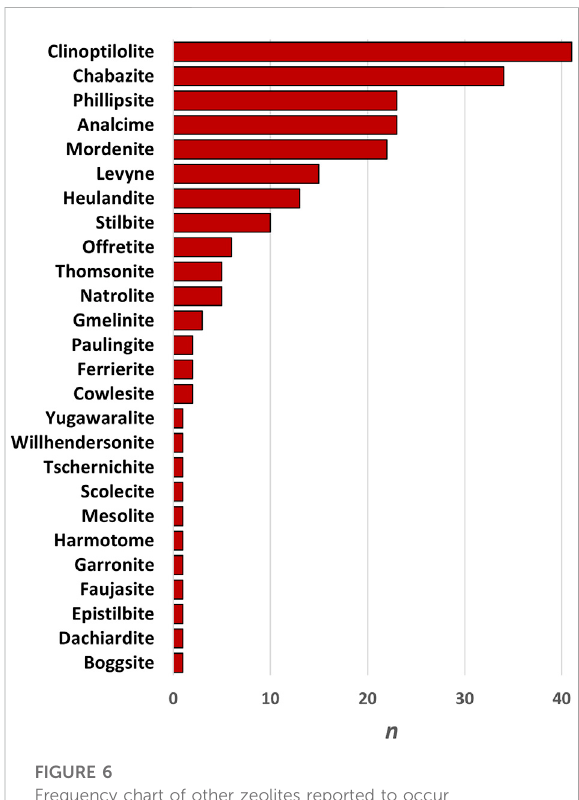
FIGURE 6 Frequency chart of other zeolites reported to occur alongside erionite,withclinoptiloliteandchabazitebeingthemost